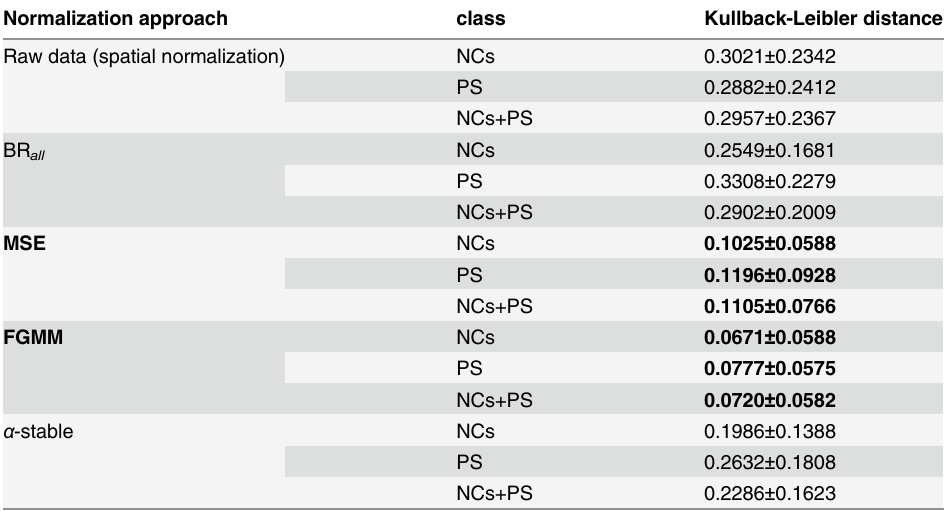
Table 2. Mean Kullback-Leibler distance and standard deviation for all images before and after intensi- ty normalization methods in the non-specific region. Normalization